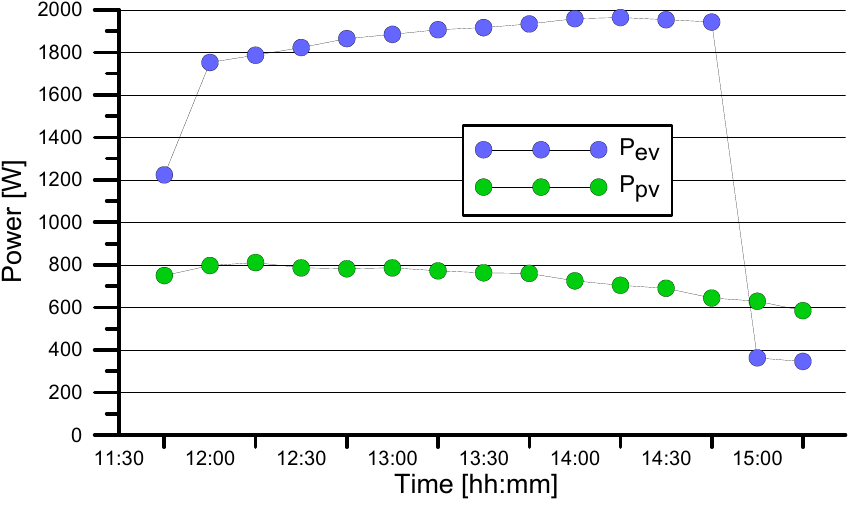
Figure 4. Graphs of the power generated by the mini carport (P pv ) and the power consumed during vehicle charging (P ev ).